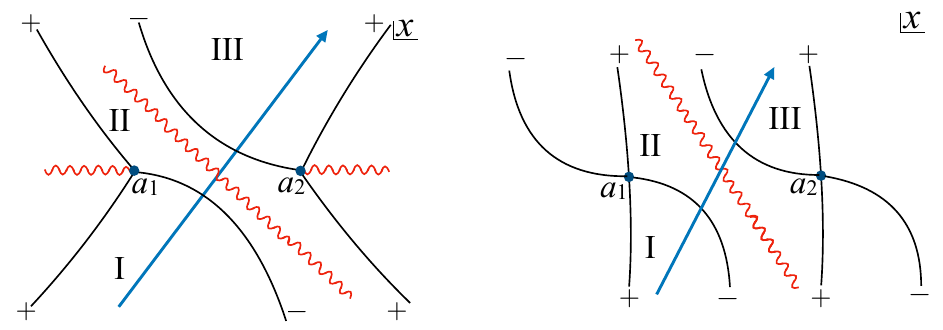
Figure 9 . The orbit we consider to compare the connection formula from Airy-type (left) and the DW-type